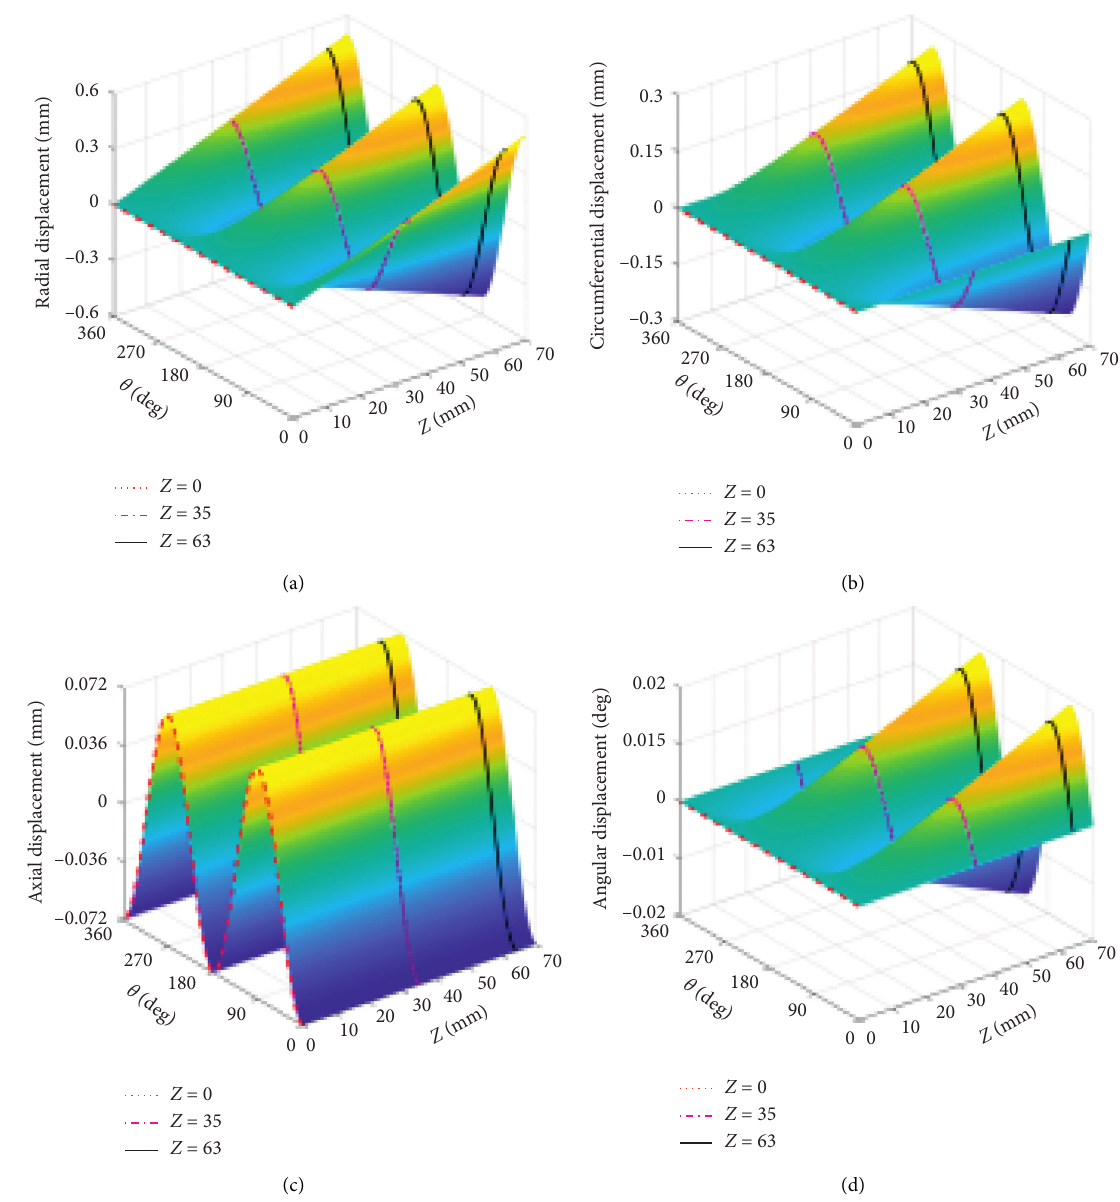
Figure 17: Spatial distribution state diagram of flexspline displacement. (a) Radial displacement. (b) Circumferential displacement. (c) Axial displacement. (d) Angular